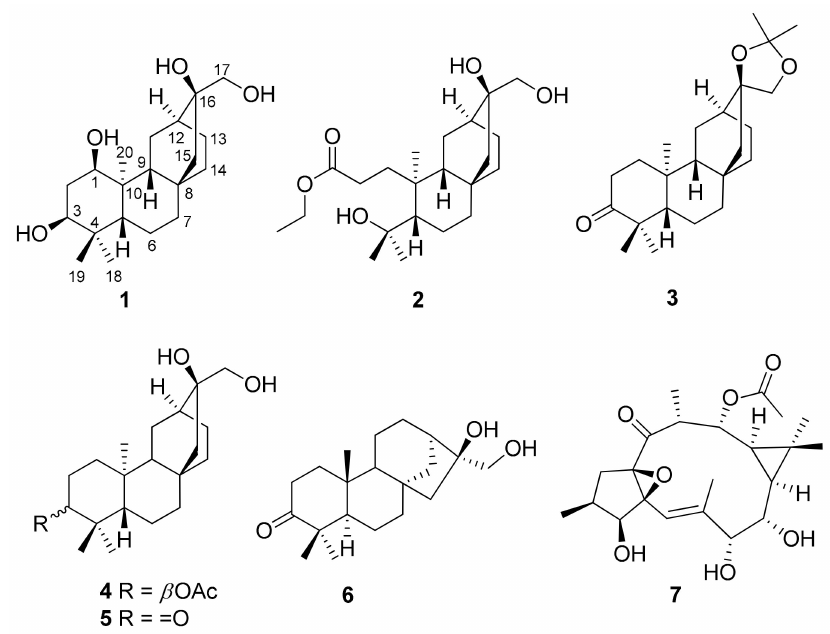
Figure 1. Chemical structures of 1 – 7